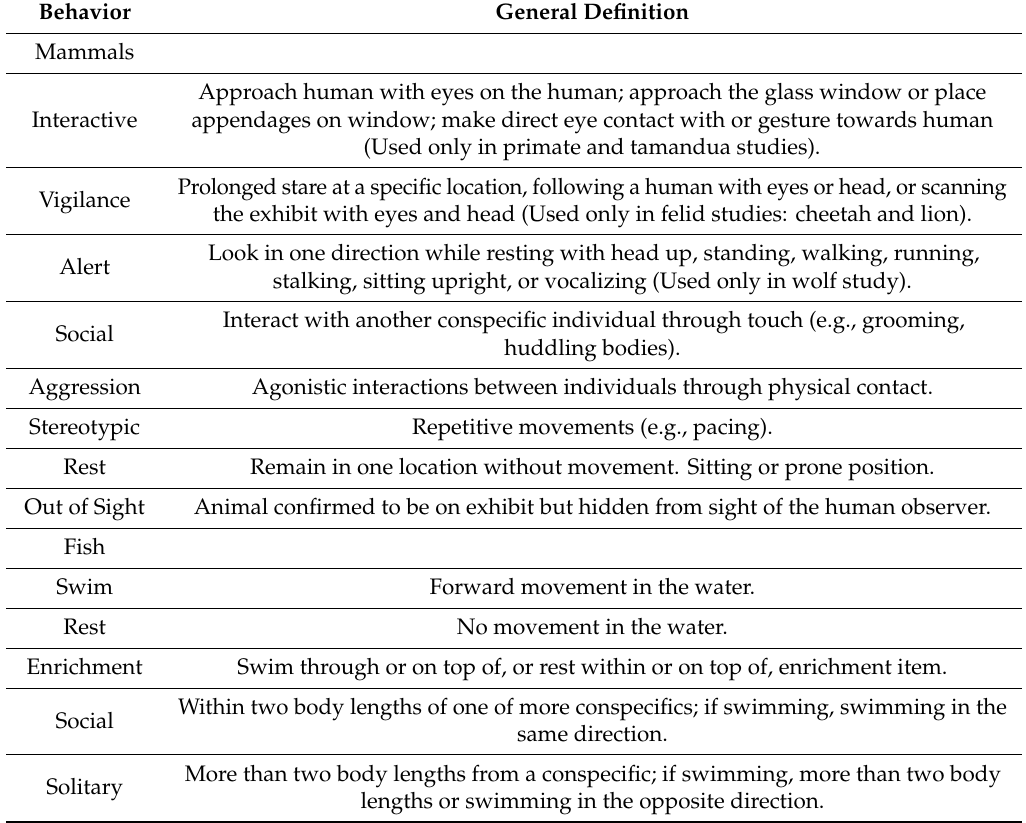
Table 3. Ethogram for the behaviors studied 1